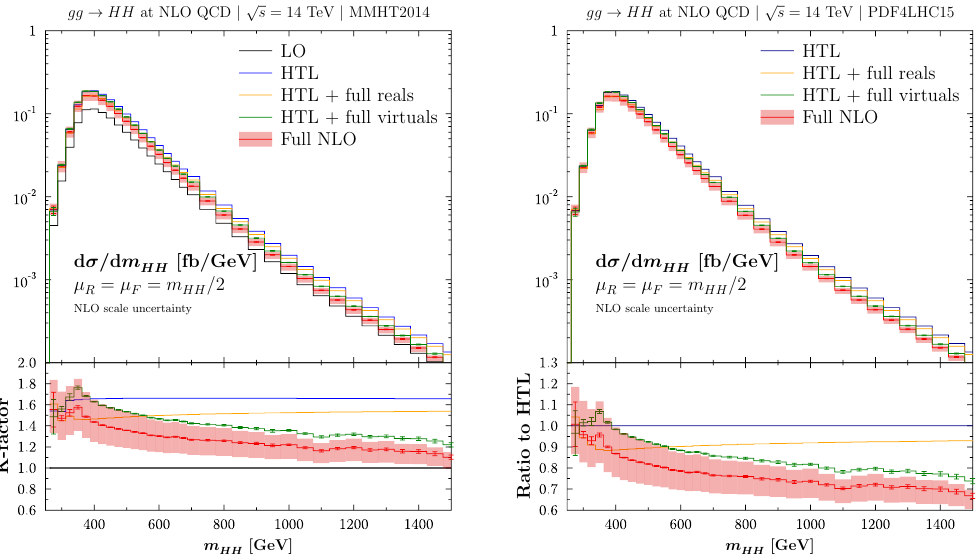
Figure 10 . Invariant Higgs-pair-mass distributions for Higgs boson pair production via gluon fusion at the 14 TeV LHC as a function of Q = m HH . LO results (in black), HTL results (in blue), HTL results including the full real corrections (in yellow), HTL results including the full virtual corrections (in green, including the numerical errors), and the full NLO QCD results (in red, including the numerical errors). Left: results with the MMHT2014 PDF set, the panel below displays the K-factors for the di(cid:11)erent results. Right: results with the PDF4LHC15 PDF set, the panel below displays the ratio to the NLO Born-improved HTL result for the di(cid:11)erent calculations. The red band indicates the renormalization and factorization scale uncertainties for results including the full NLO QCD corrections.